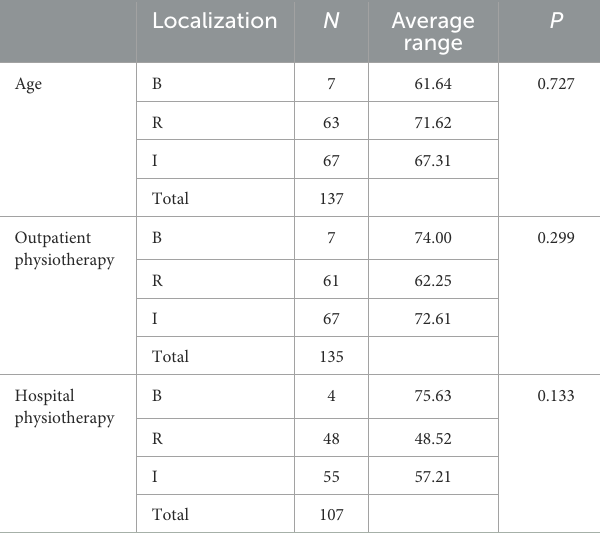
TABLE 5 Correlations of “stroke localization” with “age,” “outpatient physiotherapy,” and “hospital physiotherapy” (Kruskal–Wallis test). Localization N